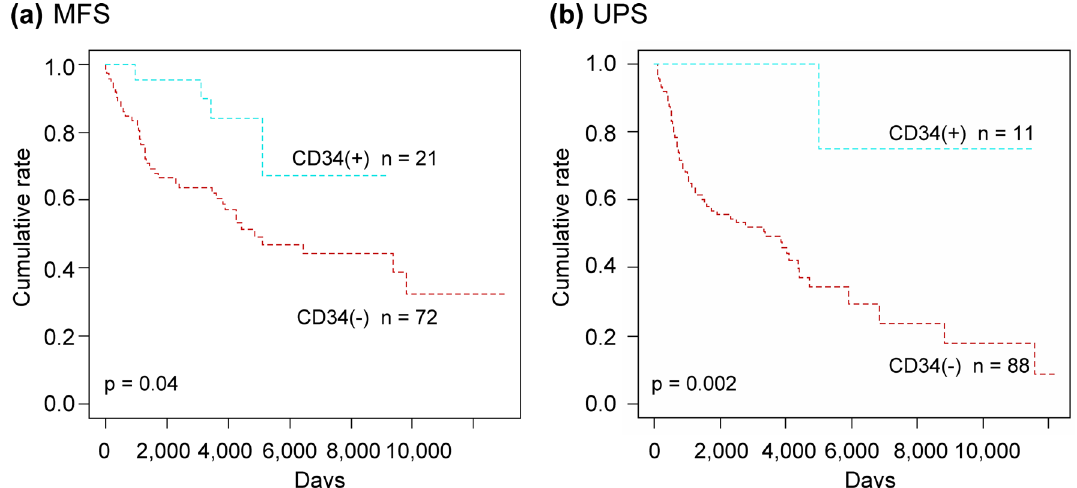
Figure 4. Overall survival of patients with myxofibrosarcoma (MFS) and undifferentiated pleomorphic sarcoma (UPS) according to CD34 status. Patients who were CD34-positive showed significantly better overall survival than did those who were CD34-negative whether they were diagnosed with MFS ( a ) or UPS ( b